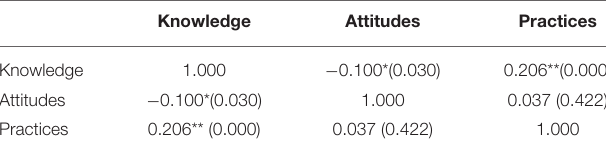
TABLE 5 | Spearman’s correlation coefficient between knowledge, attitudes and practices of dog owners regarding rabies control in